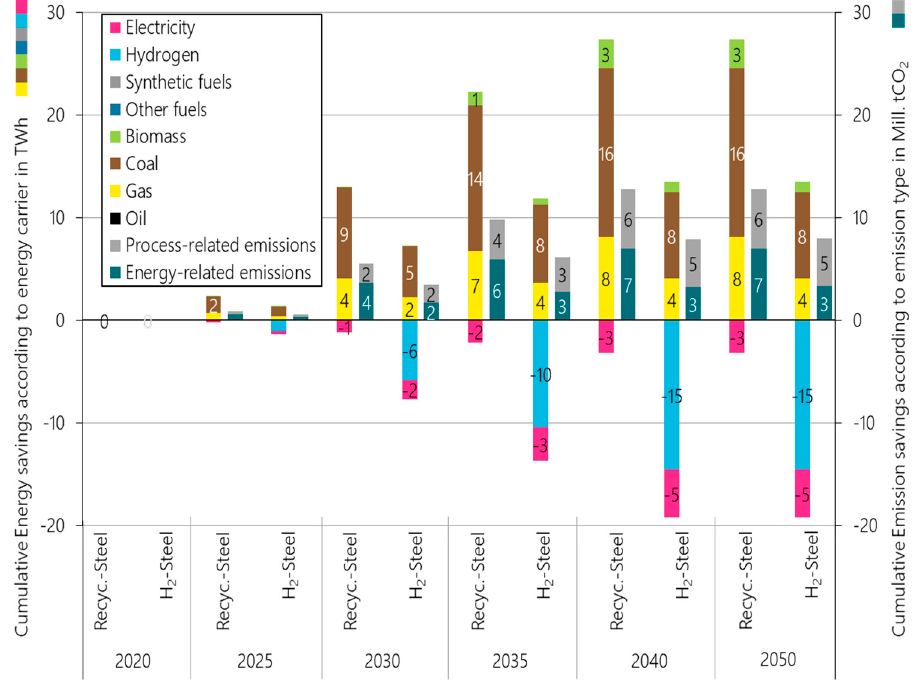
Figure 14. Changes in energy and emissions as a result of process route changes, lower/higher energy consumption compared to Reference is positive/negative, lower/higher emissions compared to Reference are positive/negative.